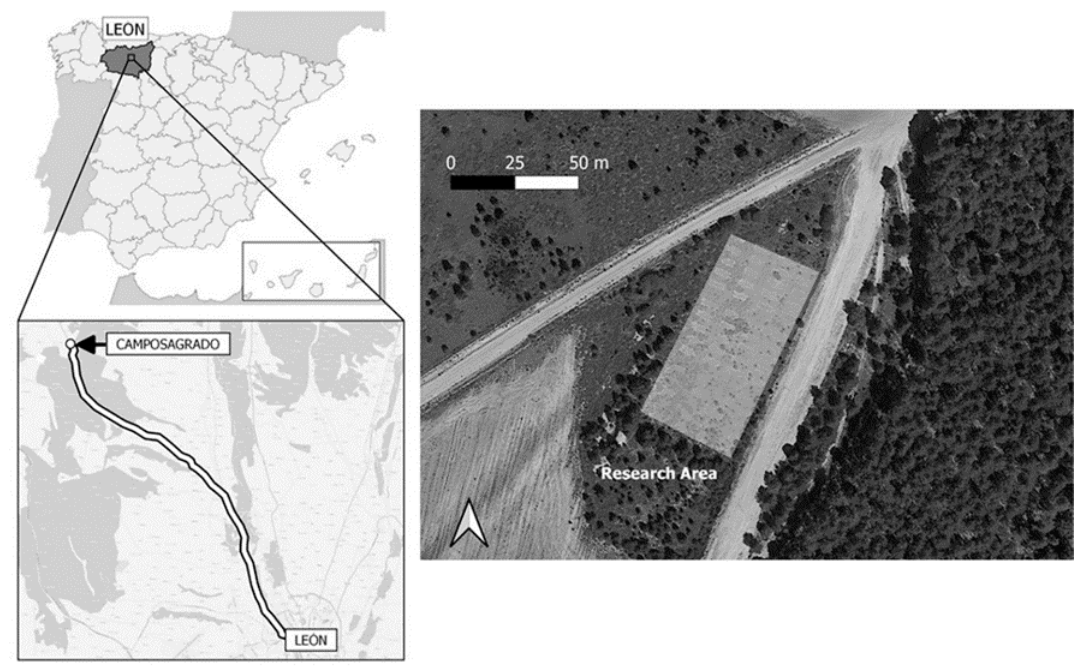
Figure 1. Location of the experimental site (scale, north orientation and experimental units within the research area are shown on the right side).